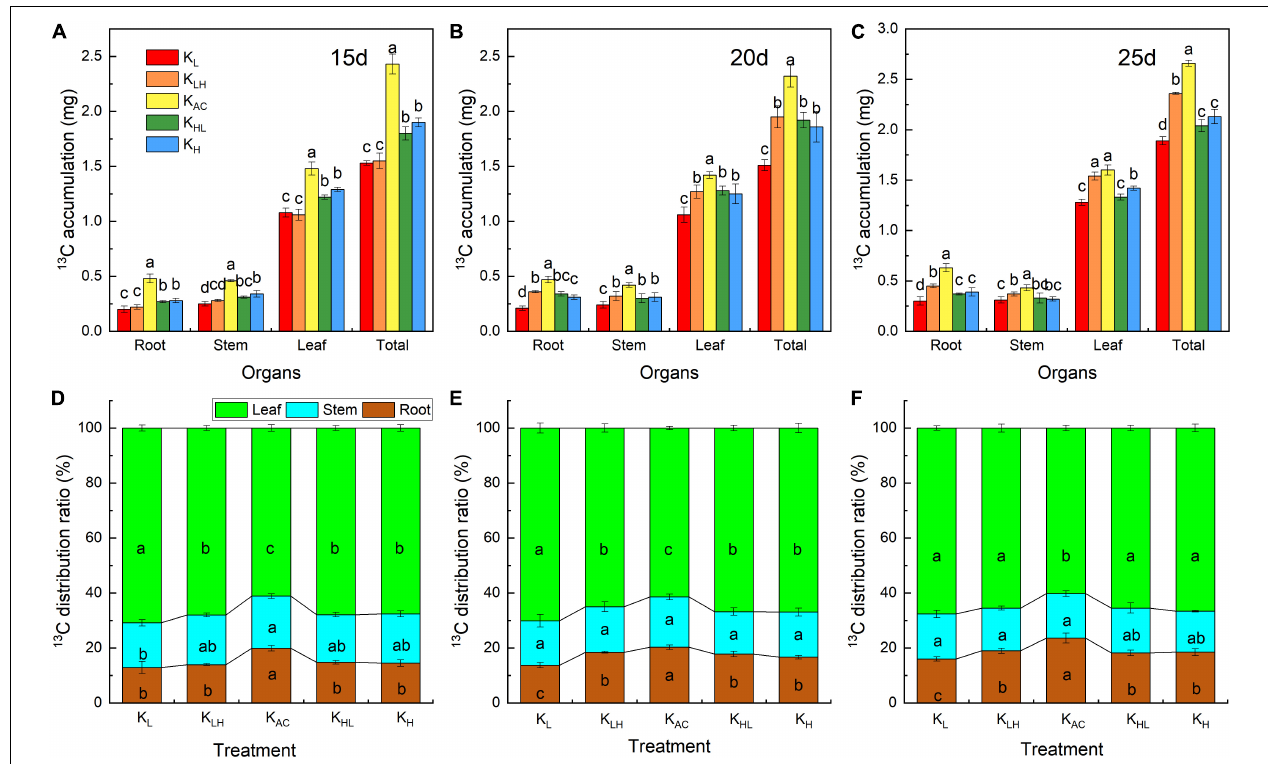
FIGURE 6 | Effects of different K treatments on 13 C accumulation (A) and 13 C distribution ratio (D) after 15 days treatments, 13 C accumulation (B) and 13 C distribution ratio (E) after 20 days treatments and 13 C accumulation (C) and 13 C distribution ratio (F) after 25 days treatments of M9T337 rootstocks. Data show the means ± standard deviation of three independent samples (three rootstocks as a sample). Different letters on vertical bars indicate significant differences ( P <